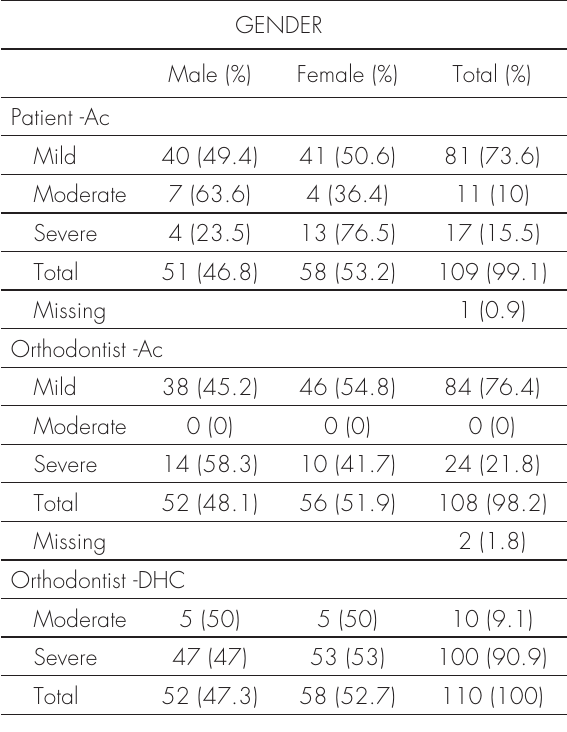
Table II. Frequency of IOTN scores by severity and gender.